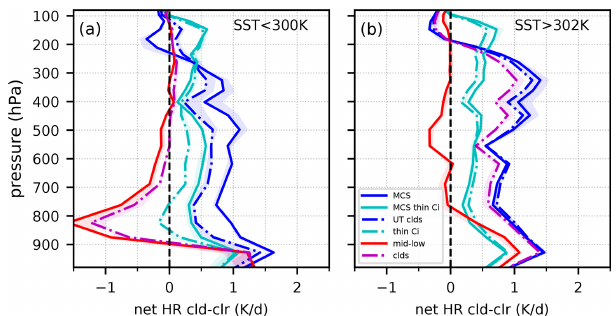
Figure 8. Tropical 24h mean cloud net radiative heating effect (ma- genta) within the troposphere above ocean, as well as the separate effects of low- and mid-level clouds (red), all UT clouds (dashed– dotted blue), thin cirrus (dashed–dotted cyan), MCSs (full blue line) and thin cirrus associated with MCSs (full cyan line), averaged over 15 ◦ N to 15 ◦ S, when the specific cloud types are present. (a) Re- gions with SST < 300K. (b) Regions with SST > 302K. These thresholds correspond to the 30% coolest and warmest tropical oceanic regions.